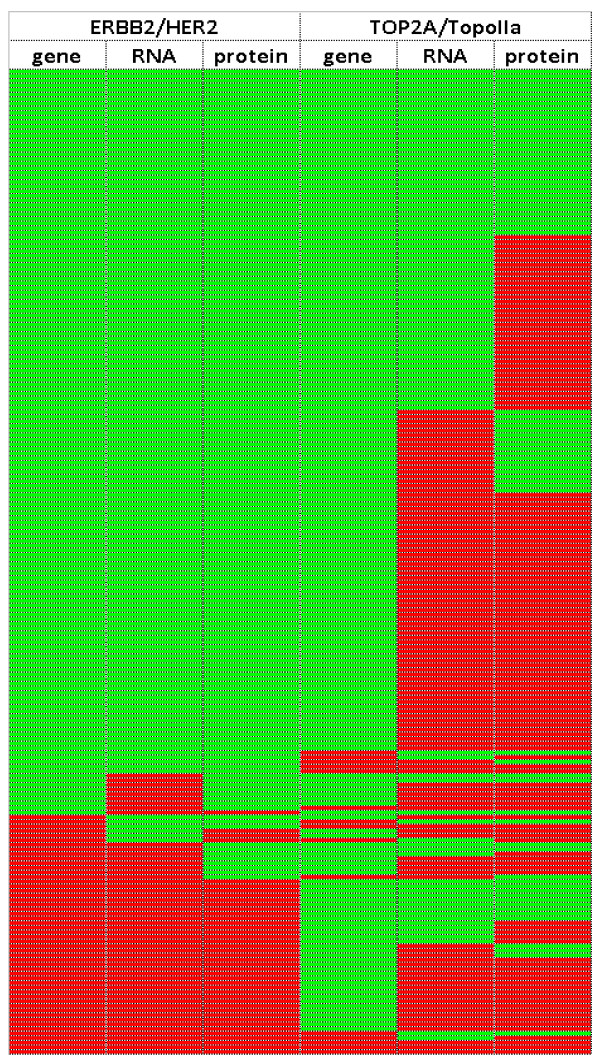
HER2 and TOP2A profiling for gene status, RNA and protein expression in adjuvantly treated breast carcinomas. Green cells: non-amplified, low mRNA expression, negative protein expression; Red cells: gene amplification, high mRNA expression, protein positivity. HER2 mRNA and protein expression exhibit different positivity patterns in comparison to TOP2A mRNA and TopoIIa protein expression. The majority of tumors with high TOP2A mRNA expression (112/121 [95.6%]) and the majority of tumors positive for TopoIIa protein expression (145/158 [91.8%]) were not amplified.